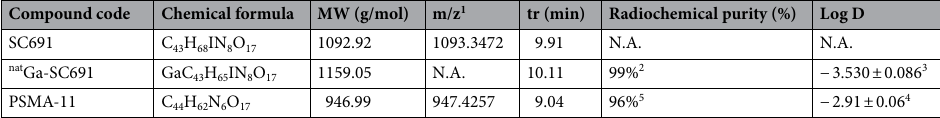
Table 1. Analytical data of SC691, nat Ga-SC691, and PSMA-11. 1 Mass spectrometry data detected as [M+H] + 2 Value for radiochemical purity measured by RP-HPLC. An Agilent analytical column (250 × 4.6 mm) was utilized with mobile phases consisting of 0.1% TFA in water ( A ) and ACN ( B ). For analytical runs, a linear gradient of solvent A (90–10% in 15 min) in solvent B at a flow rate of 1.0 mL/min was used for a 15 min run. 3 Obtained from 68 Ga-SC691. See the detailed method description in the “Materials and methods” section.